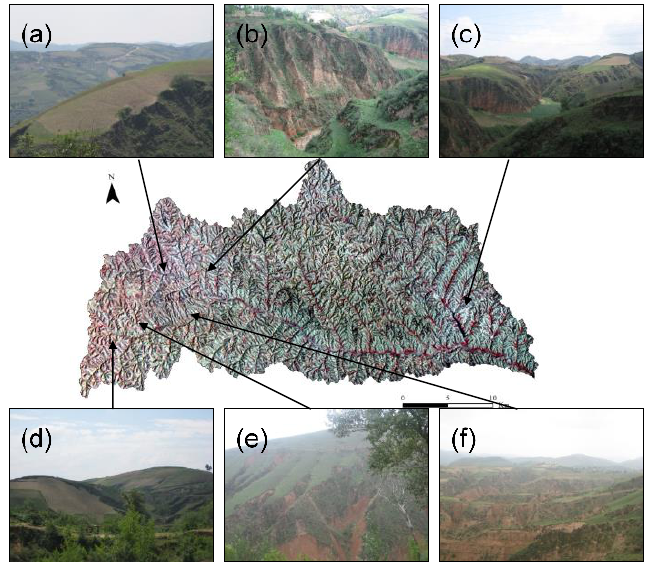
Figure 8. Hotspots with high erosion rates. ( a , b , d – f ) refer to hot spots in the upland regions, and ( c ) refers to the hot spot in the lowland area of the Xiaolihe watershed.